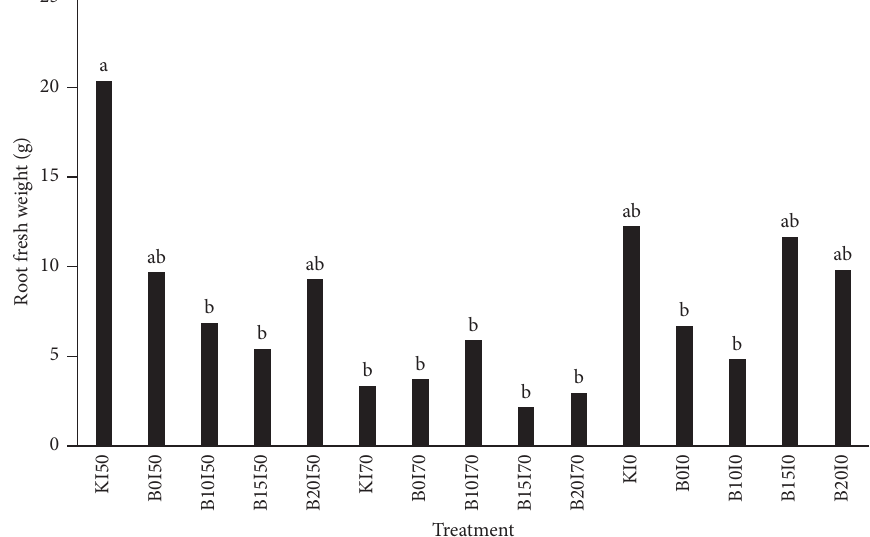
Figure 4: Root fresh weight of longevity spinach ( Gynura procumbens ) plants as affected by biochar and shade application.